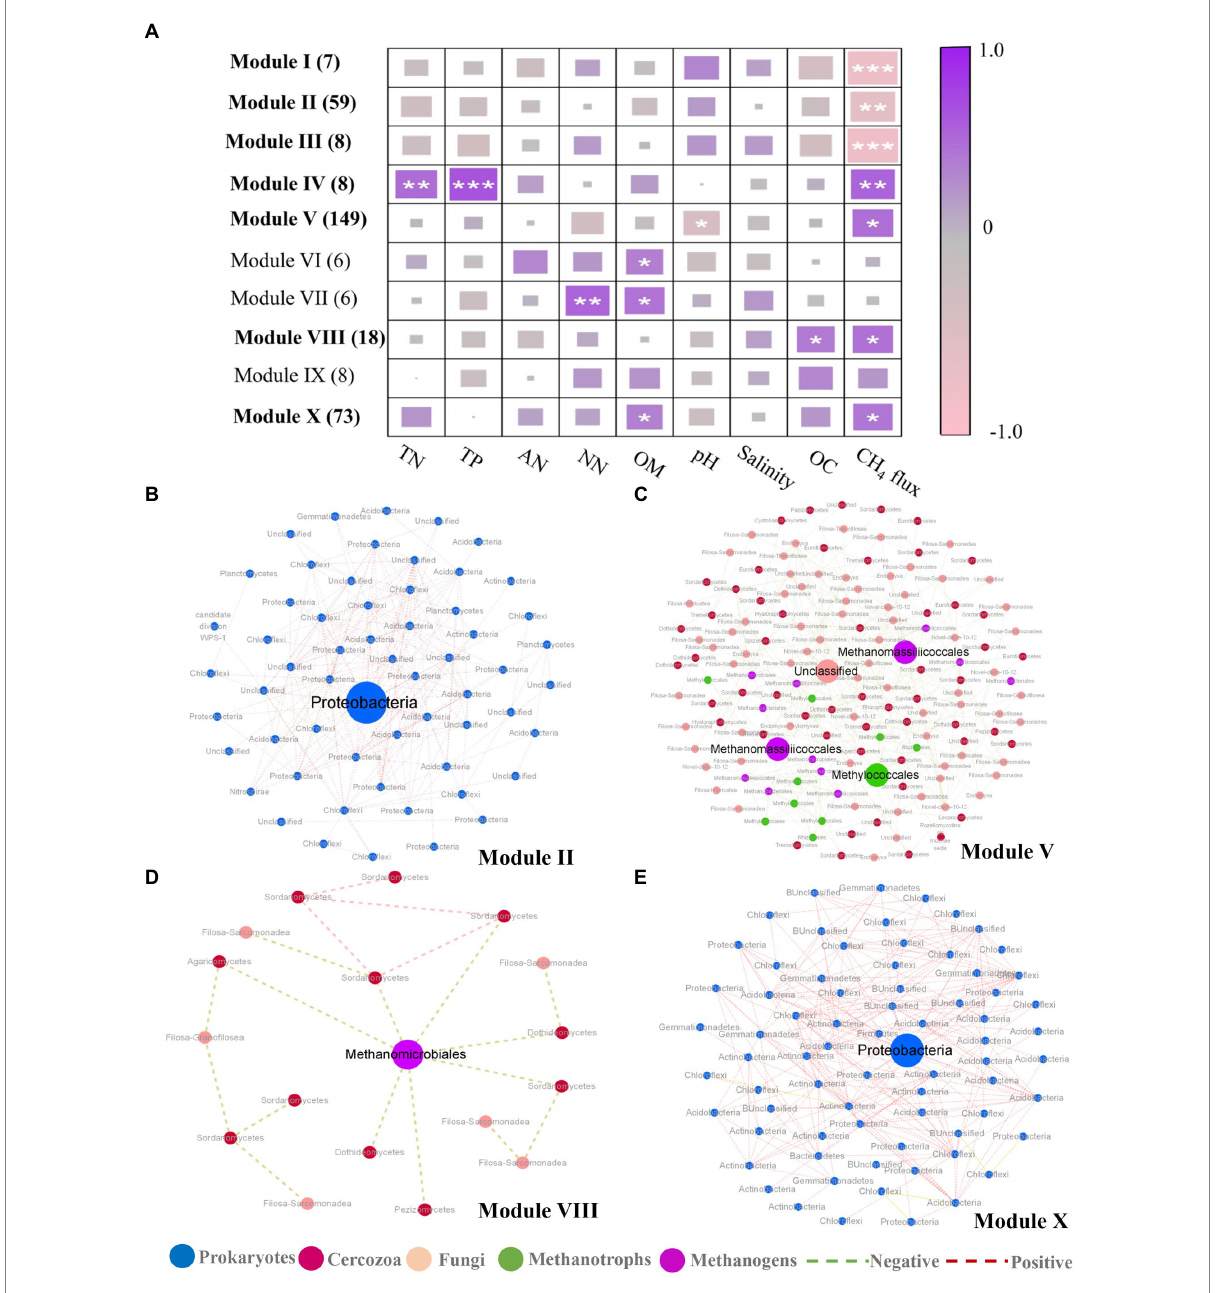
FIGURE 4 Correlation between module eigengenes and soil properties and display of related modules. (A) Correlation coefficients between module eigengenes and soil properties together with ecosystem methane (CH 4 ) under inundation treatments. The numbers in parentheses indicate the number of nodes observed in each module. Module eigengenes significantly related to CH 4 are in bold. Asterisks denote the significant relationships (* p < 0.05, ** p < 0.01 and *** p < 0.001). TN, total nitrogen; TP, total phosphorus; AN, Ammonia nitrogen; NN, Nitrate nitrogen; OC, Oxygen content. (B–E) Representative modules that were significantly related to CH 4 under inundation. In each module, node size is proportional to the network role, with larger nodes representing module hubs. Node color represents taxonomic groups. Prokaryotes (blue), cercozoa (red), fungi (pink), methanotrophic OTUs (green) and methanogenic OTUs